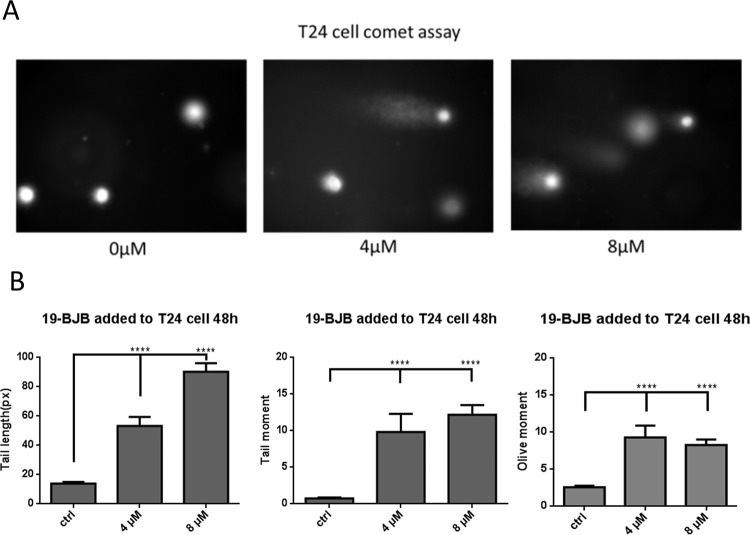
Comet assay was performed T24 cells after 48 h of 19-BJB treatment.(A) Photos observed using a fluorescence microscope. (B) Tail length, tail moment and olive moment of comet assay were measured and photomicrographs by CometScore 15. Each bar is representative of mean ± SEM of three replicates for each treatment (***p < 0.001).